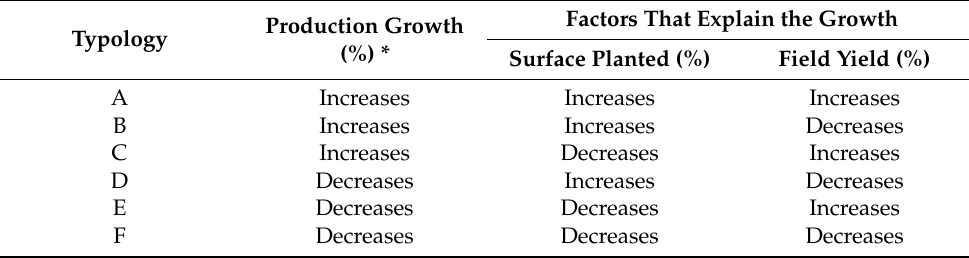
Table 1. Typology used to determine the production growth of an agricultural sector in function of the percentage variations of the surface planted and field yields. Factors That Explain the Growth Production Growth Typology (%) * Surface Planted (%) Field Yield (%) A Increases Increases Increases B Increases Increases Decreases C Increases Decreases Increases D Decreases Increases Decreases E Decreases Decreases Increases F Decreases Decreases